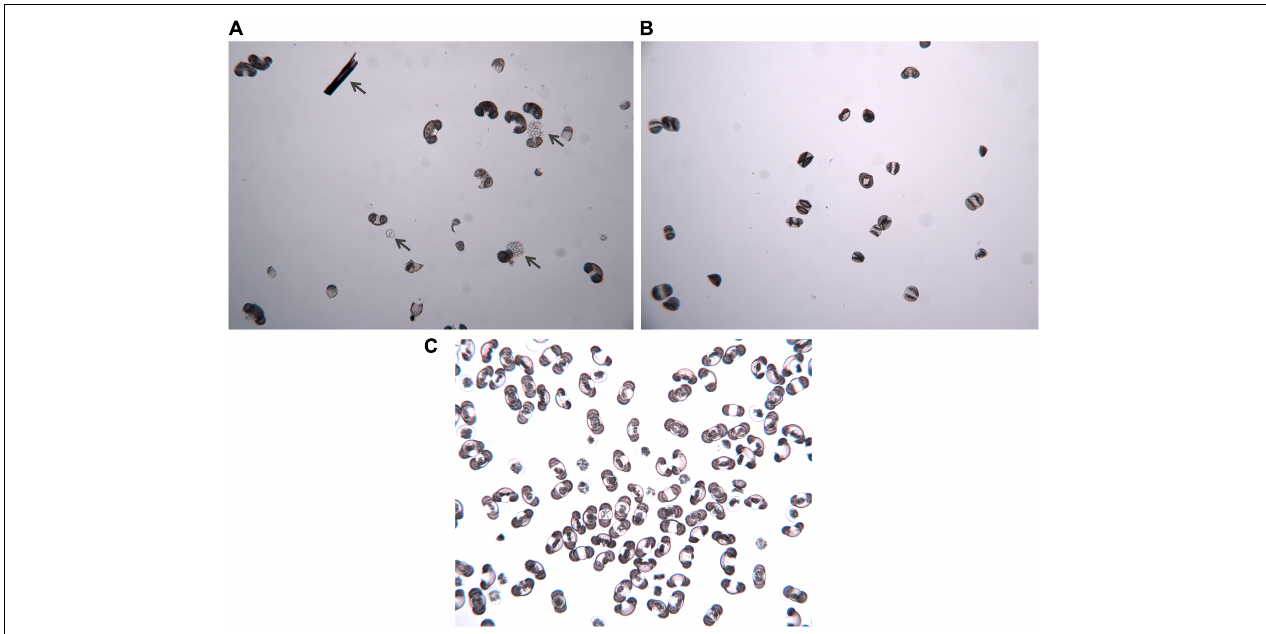
FIGURE 4 | Photos of pollen separates under 100x magnification before and after cytometric sorting. (A) Fossil sample before the sorting, with dark gray arrows highlighting organic particles that survived chemical digestion and physical sieving during pollen extraction. (B) Fossil sample after sorting, illustrating the greatly increased purity of the sample. (C) Modern pinecone sample before the sorting, illustrating the general purity of the sample, even with reduced preparation steps.